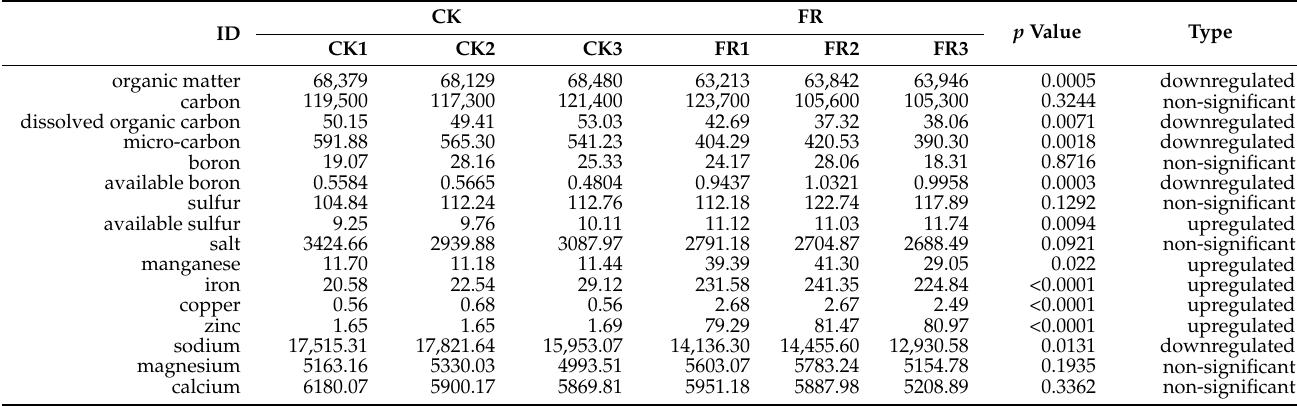
Table 3. Other properties status of soils in FR compared with CK zones in a fairy ring ecosystem. The numbers mean